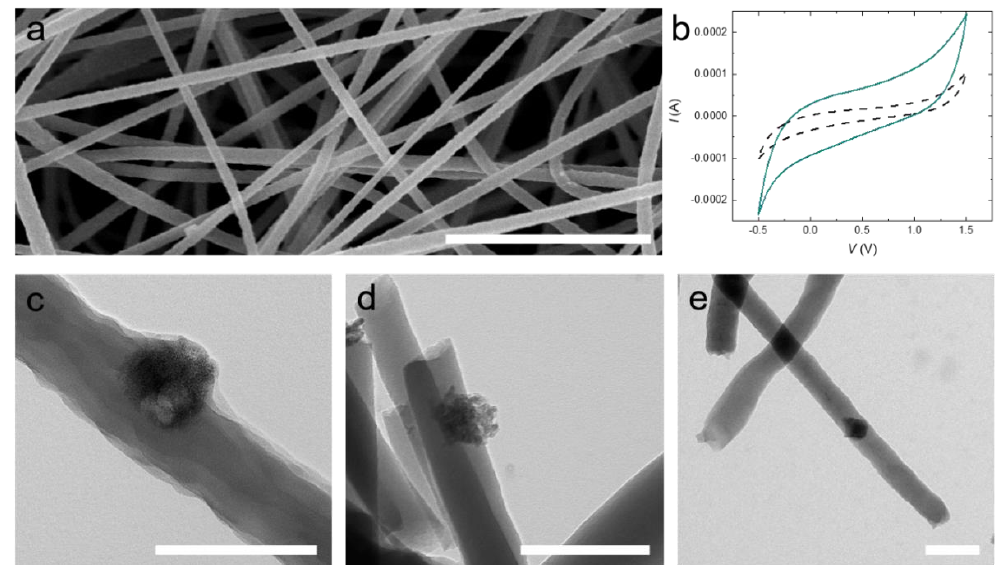
Figure 4. ( a ) SEM image of electrospun polyacrylonitrile (PAN) nanofibers containing TiON nanoparticles; ( b ) Cyclic voltammograms of uncompounded carbon-fiber-nonwovens (CFNs) (black dashed line) and CFNs containing 1 wt% TiON nanoparticles (cyan line) at a scan rate of 0.005 V/s; ( c ) TEM image of electrospun PAN nanofibers containing TiON nanoparticles; ( d ) TEM image of electrospun stabilized PAN nanofibers containing TiON nanoparticles; ( e ) TEM image of electrospun carbonized PAN nanofibers containing TiON nanoparticles. The scale bars in ( a ) = 2 µm, ( c – e ) = 200 nm.